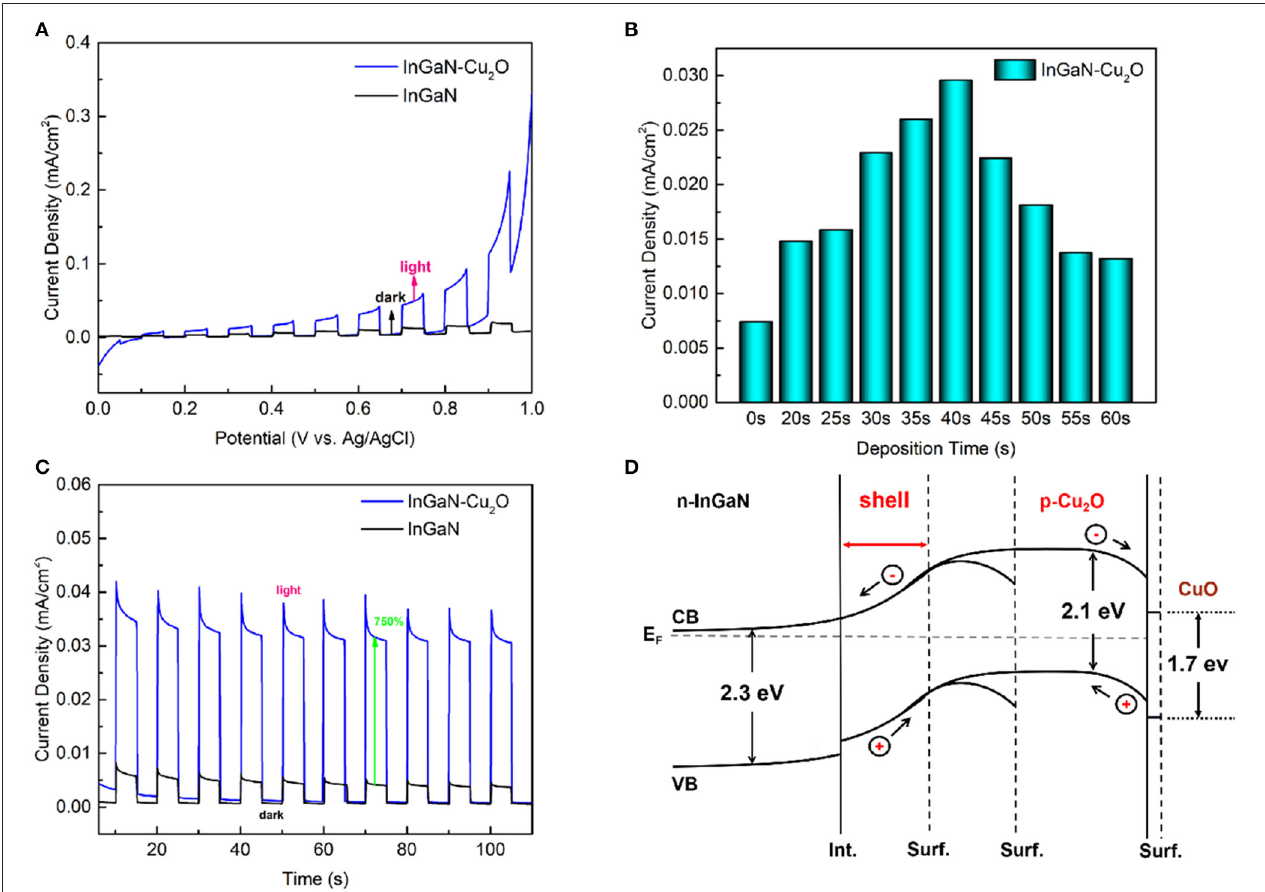
FIGURE 4 | (A) Linear sweep voltammetry measurements of the InGaN/Cu 2 O core-shell NWs and the bare InGaN NWs under chopped illumination. (B) Photocurrent density at + 0.6V vs. Ag/AgCl (1.2V vs. reversible hydrogen electrode [RHE]) as a function of the Cu 2 O electrodeposition time. (C) I–t measurements at + 0.6V vs. Ag/AgCl (1.2V vs. RHE) of the InGaN/Cu 2 O core-shell NWs and the bare InGaN NWs under chopped illumination. (D) Scheme of the InGaN/Cu 2 O energy band diagram and photogenerated carrier transport for increasing Cu 2 O layer thickness. Int. indicates the InGaN/Cu 2 O interface and Surf. indicates the surface of Cu 2 O shell-layers with different thicknesses. The thin CuO surface layer is also